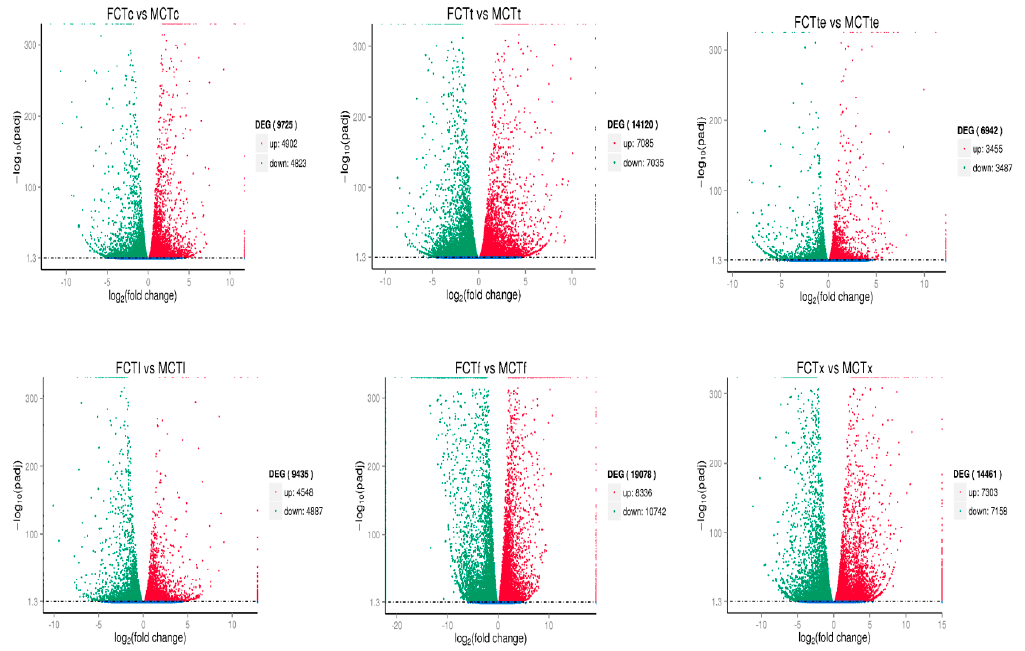
Figure 5. Differential gene expression analysis of two group samples (female vs. male).